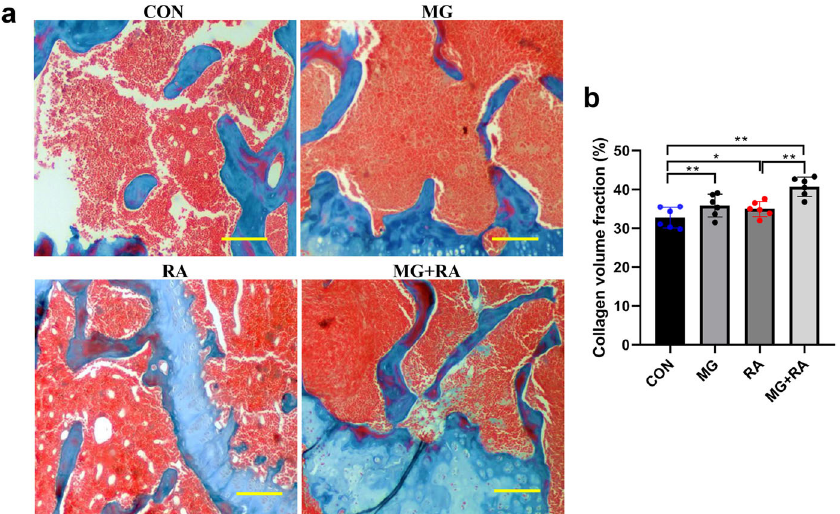
Fig. 5 Hindlimb unloading and X-ray radiation aggravated osteopenia development in rat femurs as evidenced by Masson staining. a Representative Masson staining images of rat distal femurs in the four groups and the blue part indicates collagen (scale bars, 50 µm). b Collagen volume fraction of four groups in rat femurs ( n = 6). The data are expressed as the mean ± SD. * P < 0.05, ** P < 0.01, *** P < 0.001, ns not signi fi cant.